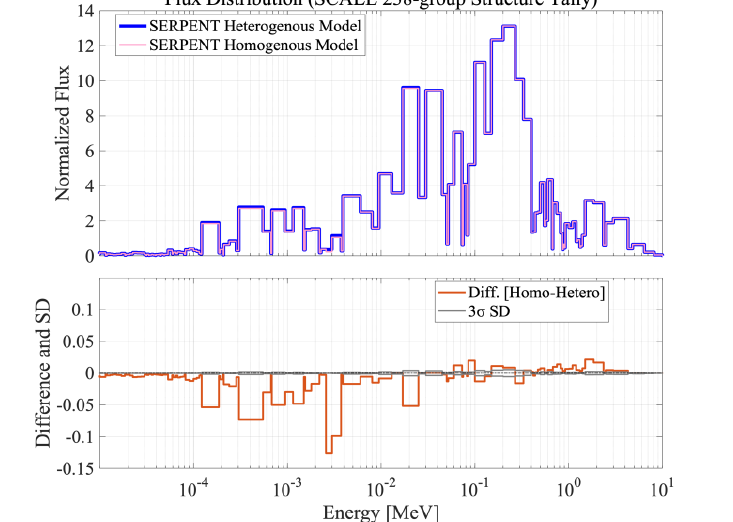
Figure 3. Normalized neutron flux distribution comparison as function of energy. (Predicted Critical State with 72 FAs, RE2 at 70